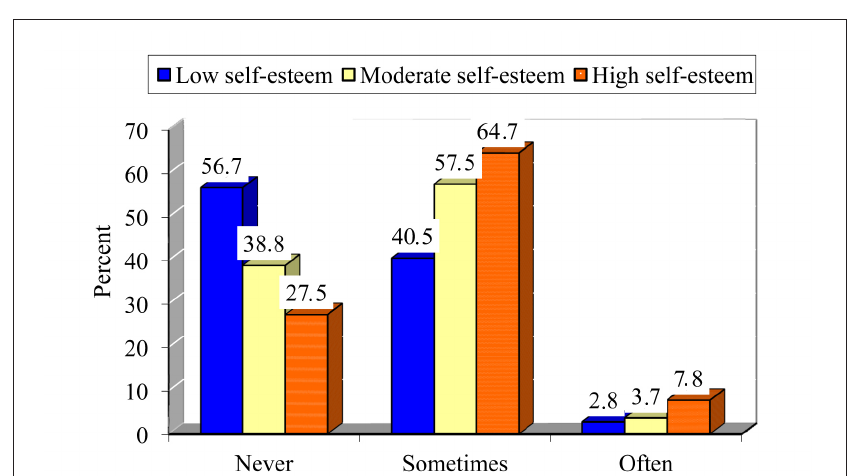
Figure 1. Percentage distribution of bullying experienced by